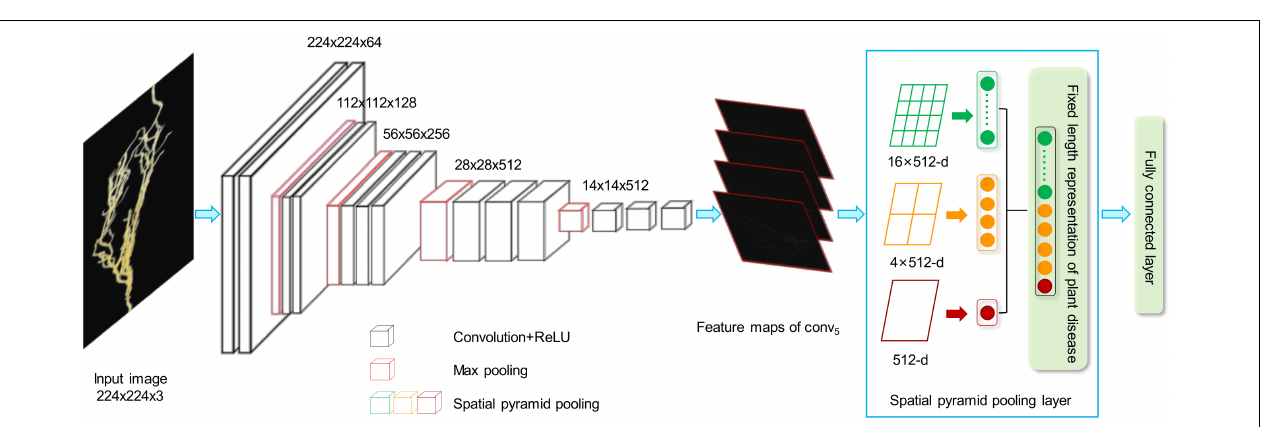
FIGURE 1 | The flowchart of the proposed framework. ReLU, Rectified Linear Unit.